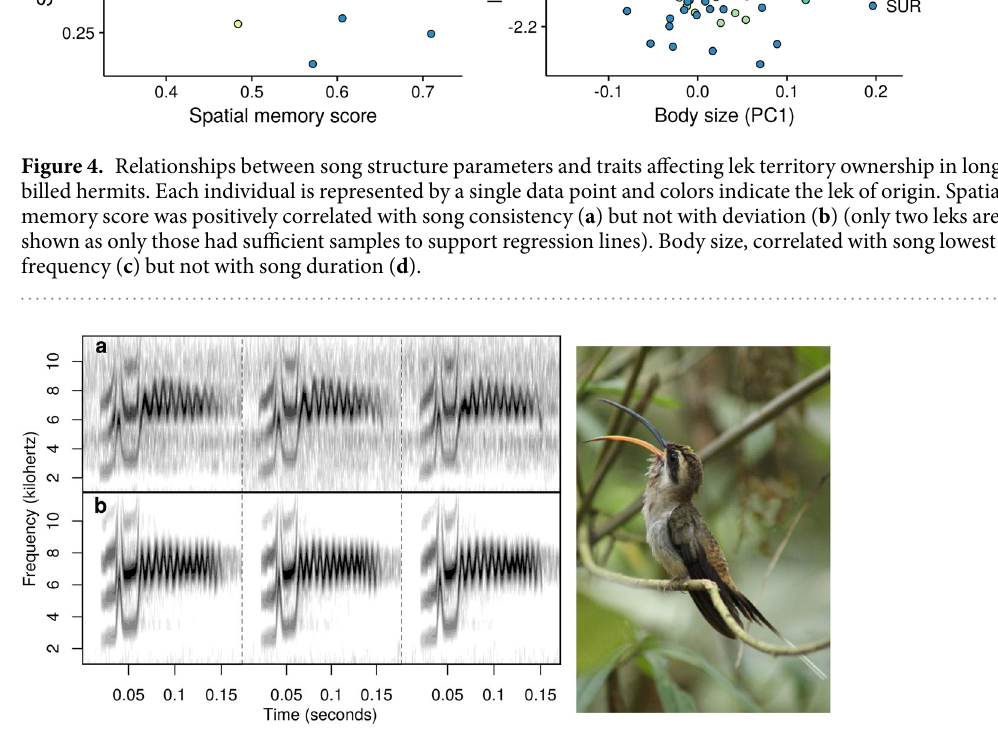
Figure 5. Spectrograms of long billed hermit vocalizations for males with ( a ) low (mean cross-correlation: 0.66) and ( b ) high song consistency (mean cross-correlation: 0.86) that share the same song type. The graph shows three of the five songs with the highest signal-to-noise ratio that were used in the song consistency analysis for the two individual. Photo (by Jeremy Gatten) illustrates a territorial long-billed hermit singing on a lek